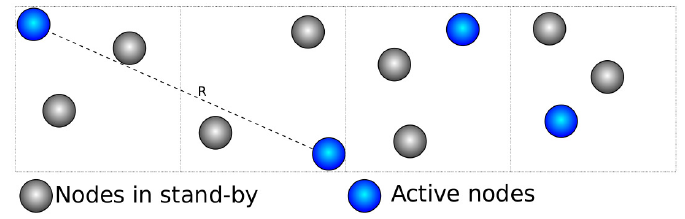
Figure 4. Geography-informed Energy Conservation for Ad Hoc Routing